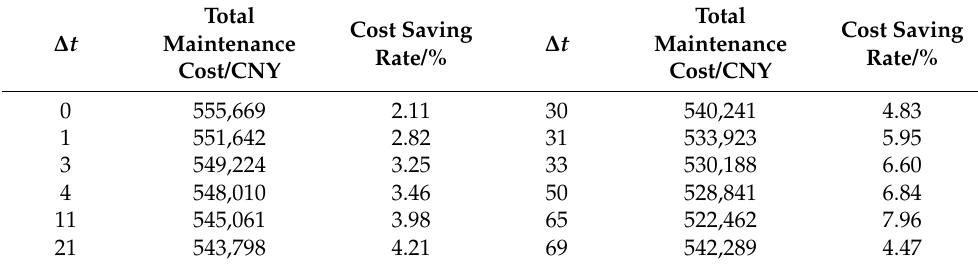
Table 6. Result of group preventive maintenance model.